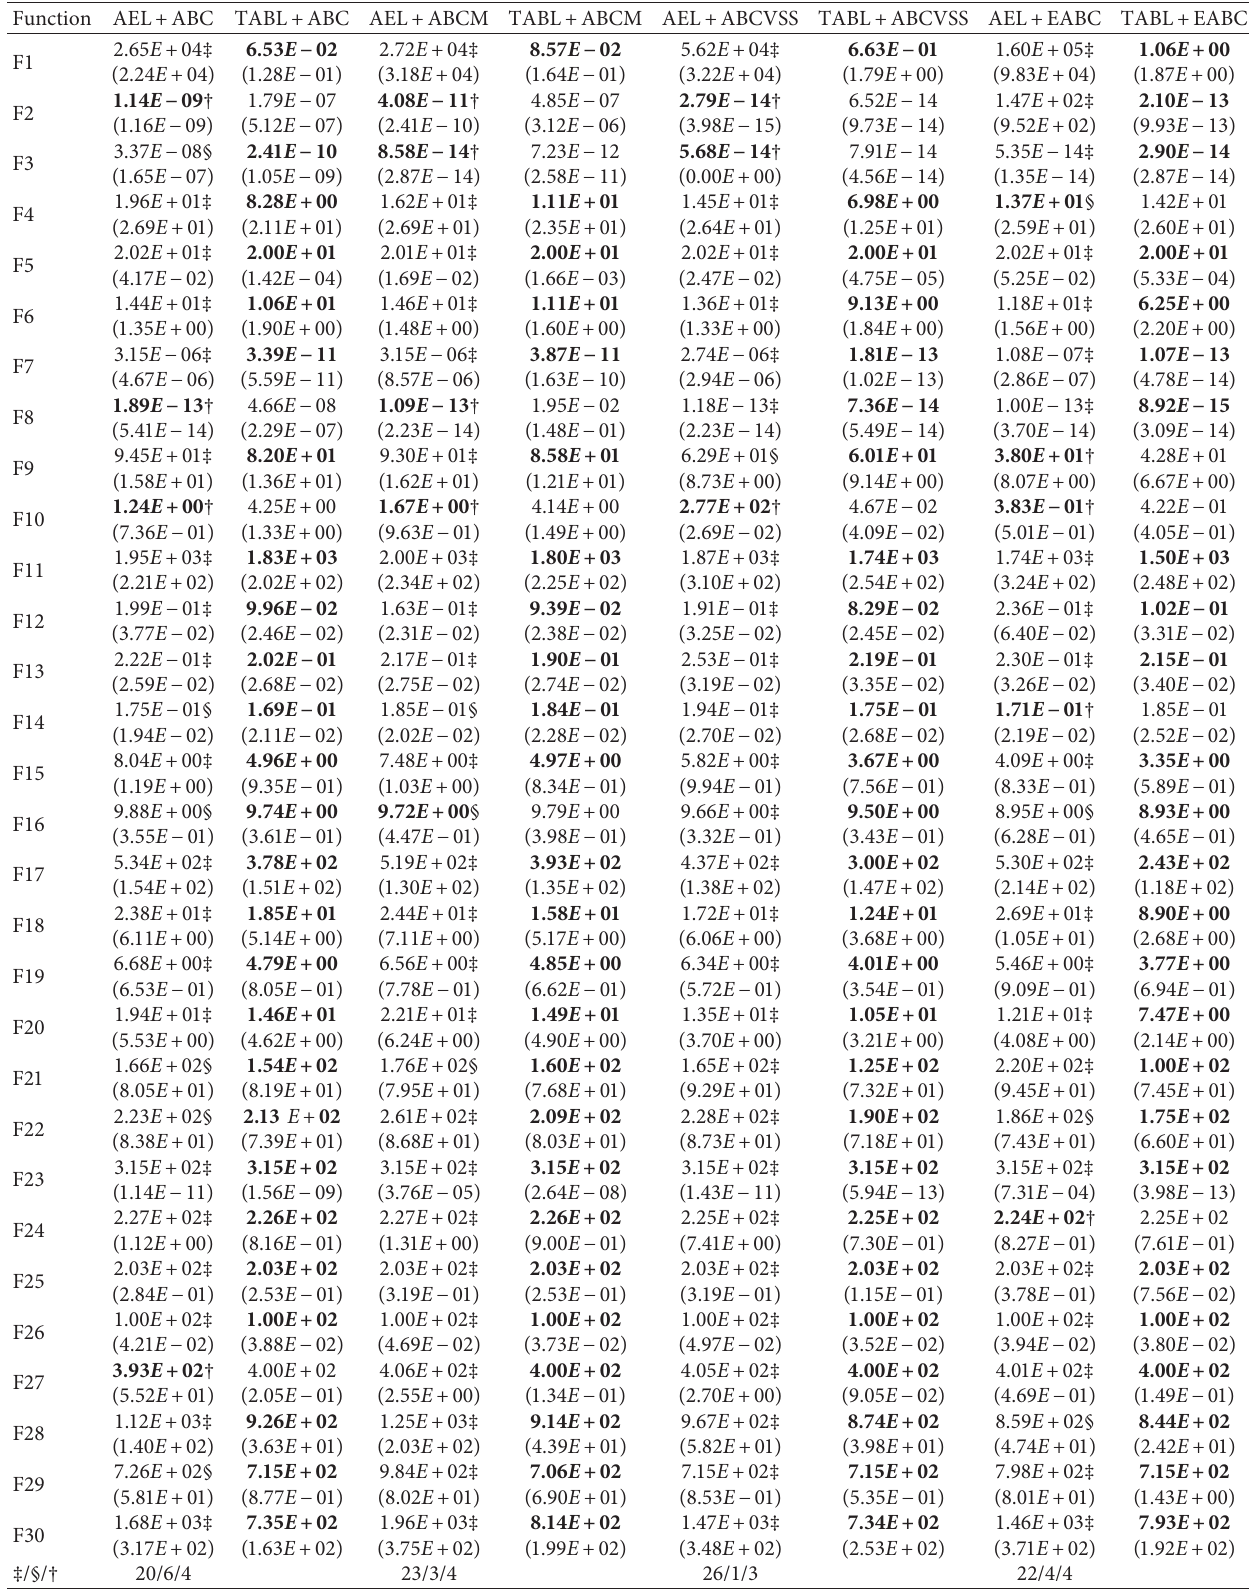
Table 3: The statistical results (mean (Std)) of AEL +GABC vs. TABL +GABC, AEL+ MABC vs. TABL+MABC, AEL +OPIABC vs. TABL+OPIABC, and AEL+qABC vs. TABL +qABC over 51 independent runs on the CEC2014 benchmarks with 30 D